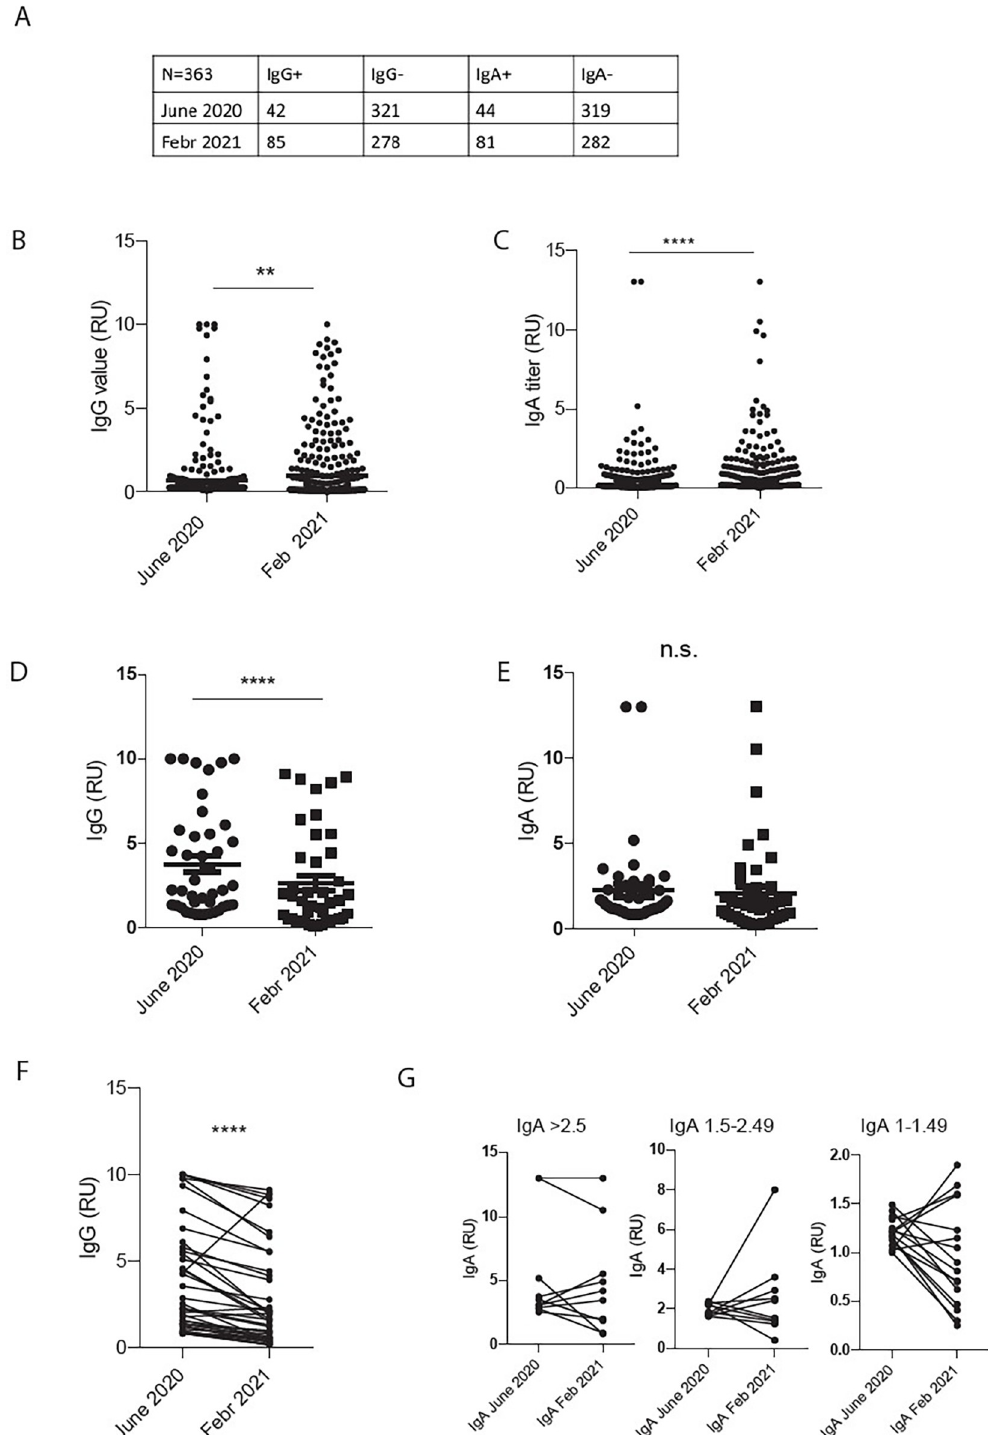
Fig 1. Immunoglobulin titers measured in June 2020 and February 2021. Table depicting numbers of participants with above-threshold titers for respective Igs (A). Vertical scatter plots of IgG (B) and IgA (C) titers derived from all participants at two time points, and of IgG (D) and IgA (E) titers from participants who tested positive in June 2020. Plots depicting IgG (F) and IgA (G) titers as in (D,E) but with lines connecting data points of each individual. Statistical analysis was performed using Student’ s t-test ( �� p < 0.01, ���� p < 0.0001).